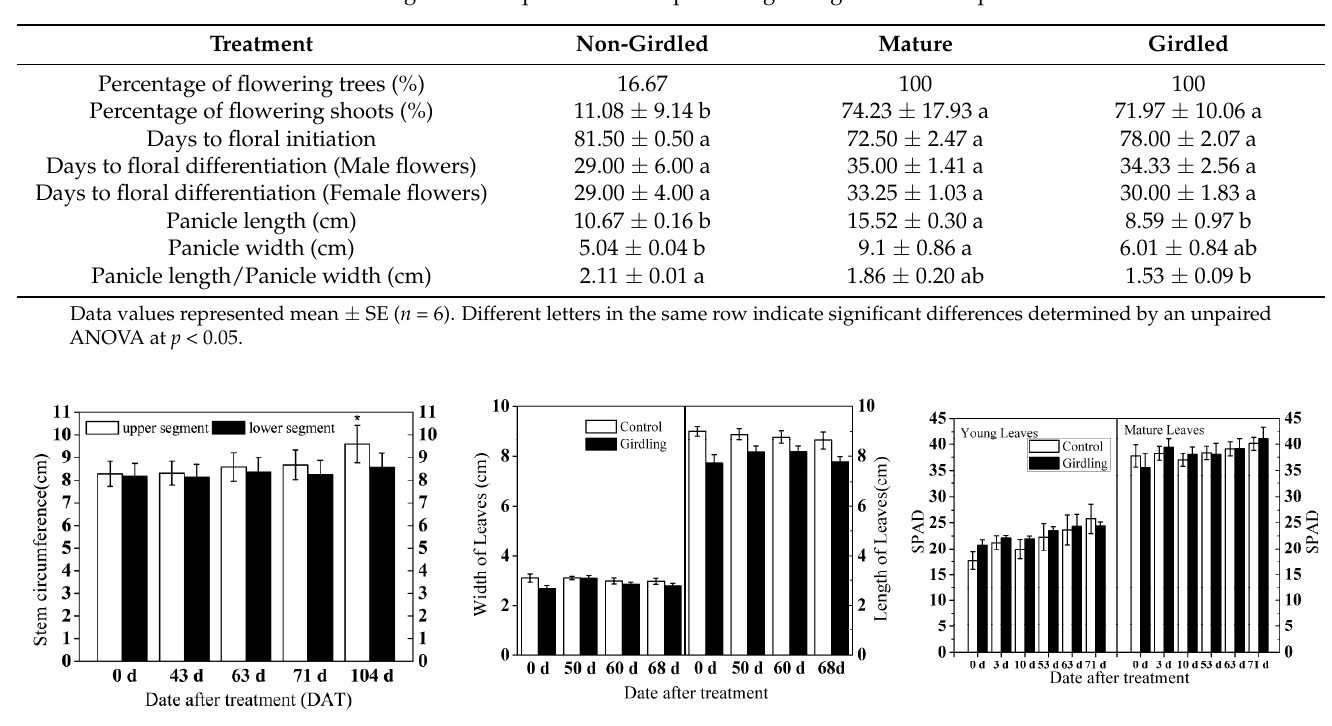
Data values represented mean ± SE ( n = 6). Different letters in the same row indicate significant differences determined by an unpaired ANOVA at p < 0.05.